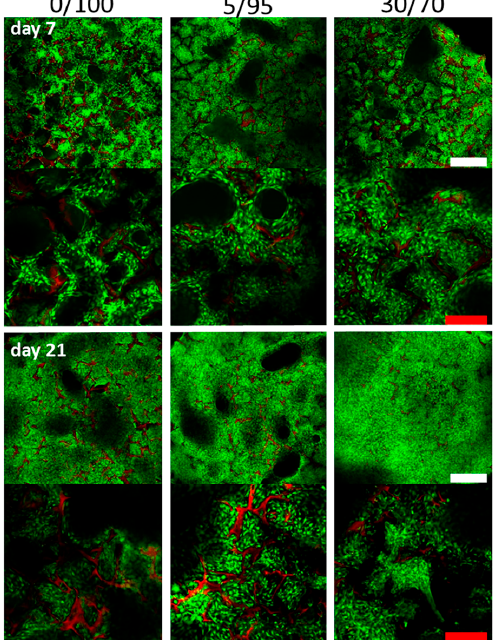
Figure 3. Confocal imaging after Calcein staining at day 7 and day 21 after cell seeding (upper rows ×4 magnification, lower rows ×10 magnification) depicting three dimensional adhesion of cells in primary and secondary pores in the center of the scaffolds. Visually, no differences between adhesion patterns and cell densities are detected. Green = Calcein-labeled cells; red = scaffold. (White scale bars = 500 µm, red scale bars = 250 µm).